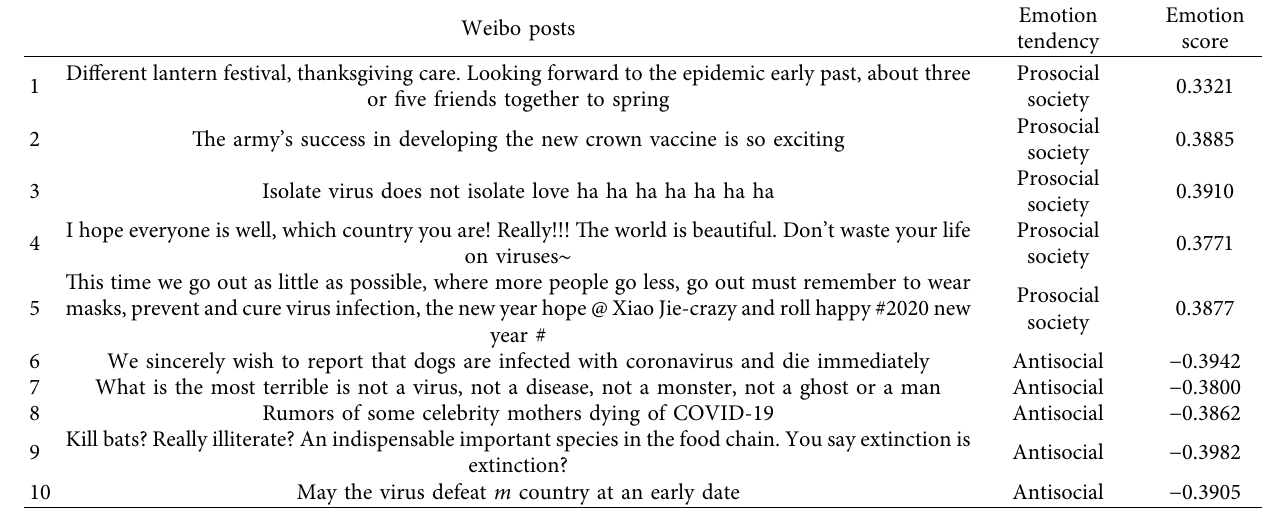
Table 1: Examples of prosocial and antisocial Weibo posts and their emotion scores.